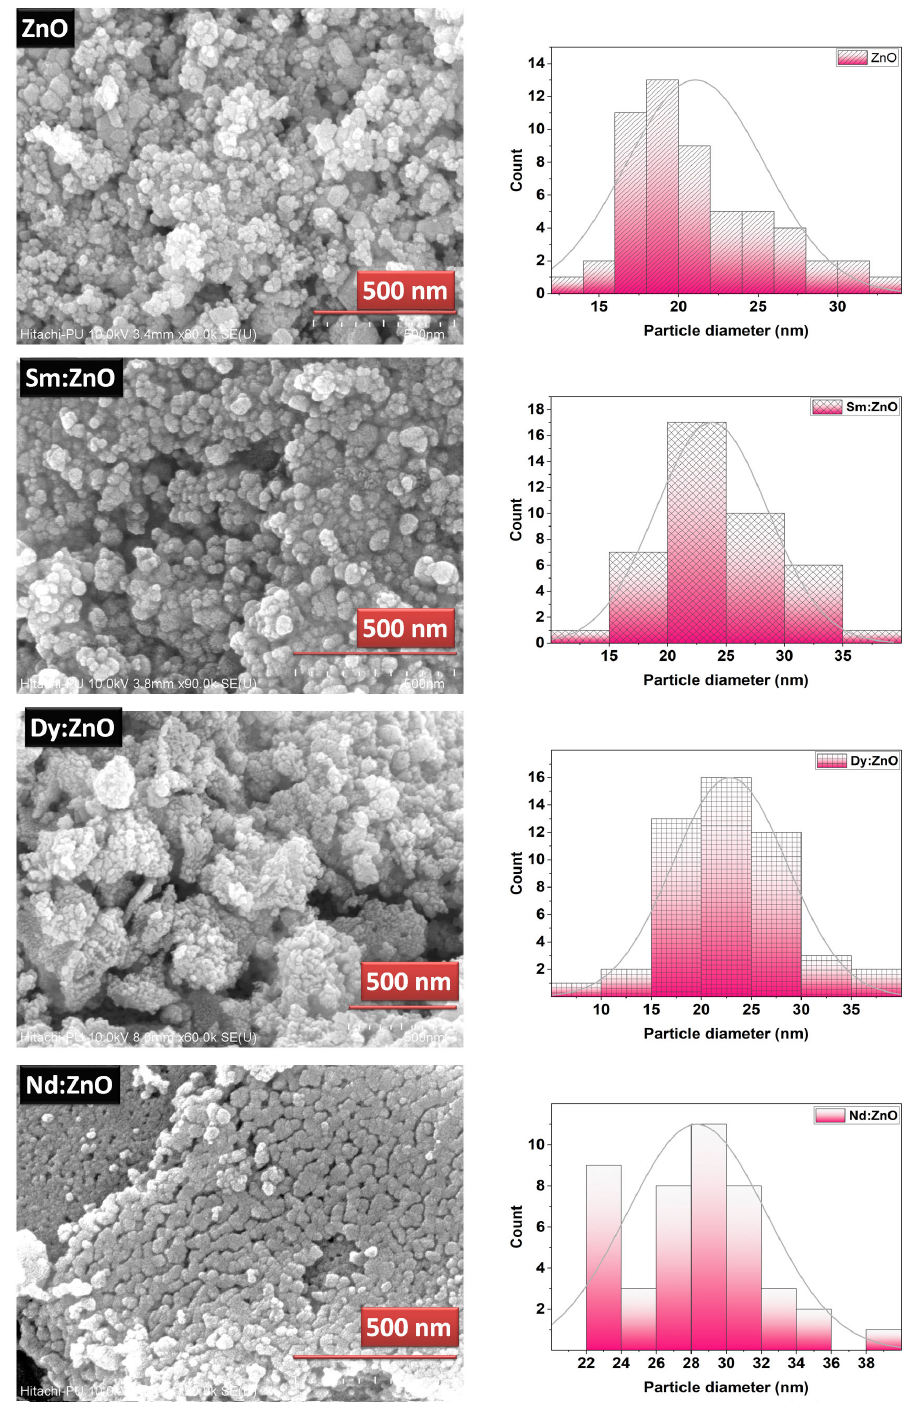
Figure 3. SEM images and corresponding grain size distribution plots for synthesized nanoparti ‐ cles.